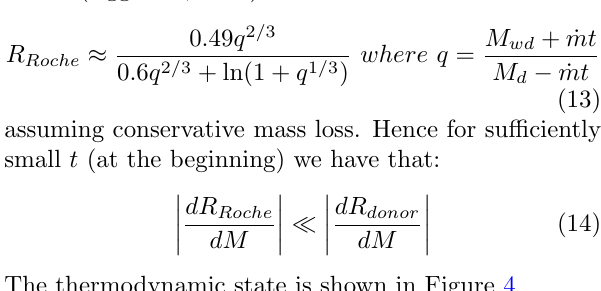
Figure 5: The time depended mass loss from the